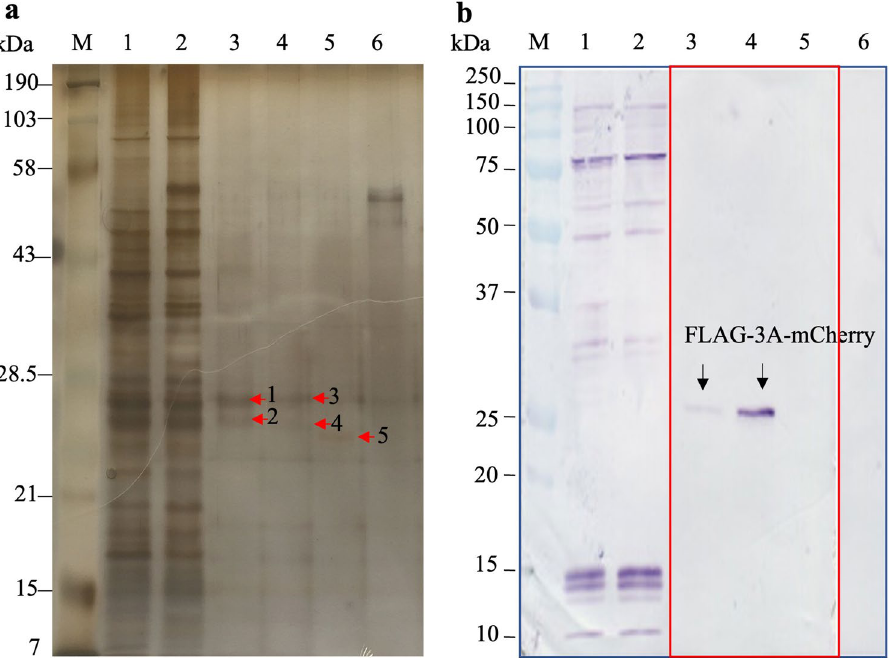
Figure 1. ( a ) Pull down of proteins with EV-A71 3A in the cell lysate prepared from pLVX-Puro::FLAG-3A- mCherry -transfected SH-SY5Y cells. Lane 1, cell lysate prepared from untransfected SH-SY5Y cells; lane 2, cell lysate prepared from pLV-mCherry transfected SH-SY5Y cells; lanes 3–5, eluate fractions from pull down by anti-FLAG M2 magnetic beads; lane 6, last washed fraction. The proteins were resolved in 12% SDS-PAGE and stained with Coomassie brilliant blue followed by counterstaining with silver dye. Red arrows indicate distinguishable protein bands excised and subjected for protein identification. ( b ) Western blot analysis of the respective pull down fractions of ( a ) to detect the FLAG-3A-mCherry (indicated by arrows) using rabbit anti-mCherry polyclonal antibody. The lanes 3–5 (in red box) on blotted membrane were cropped and moved to area on the membrane that align lanes with those in the gel ( a ). The original gel of Fig. 1a was shown in Supplementary Fig. 2.